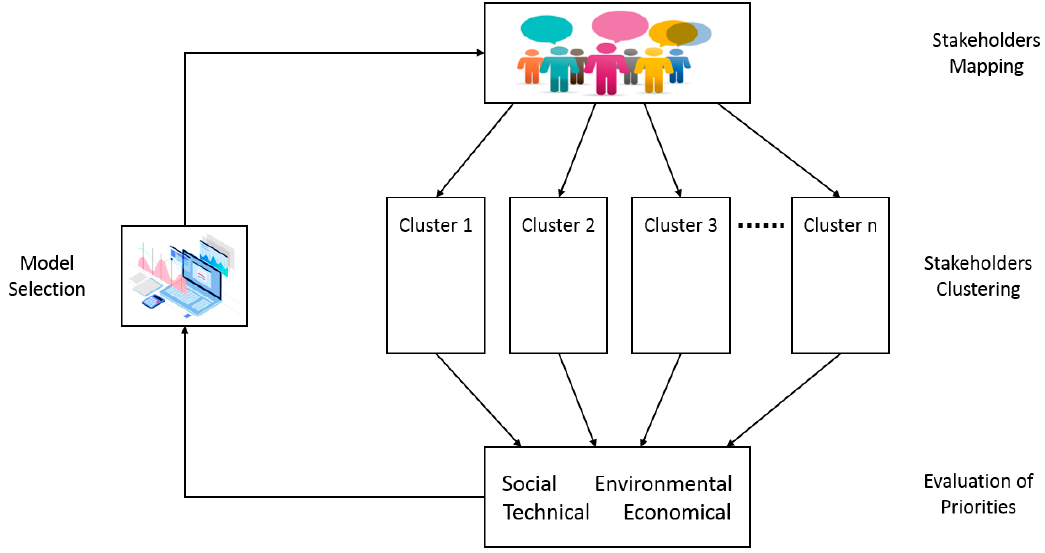
Figure 1. Hydrological Assessment and Management of green Infrastructure to Enhance Decision- making (HAMIED): A framework to adapt the optimal Sustainable Urban Drainage Systems (SuDS) modelling approach according to stakeholders’